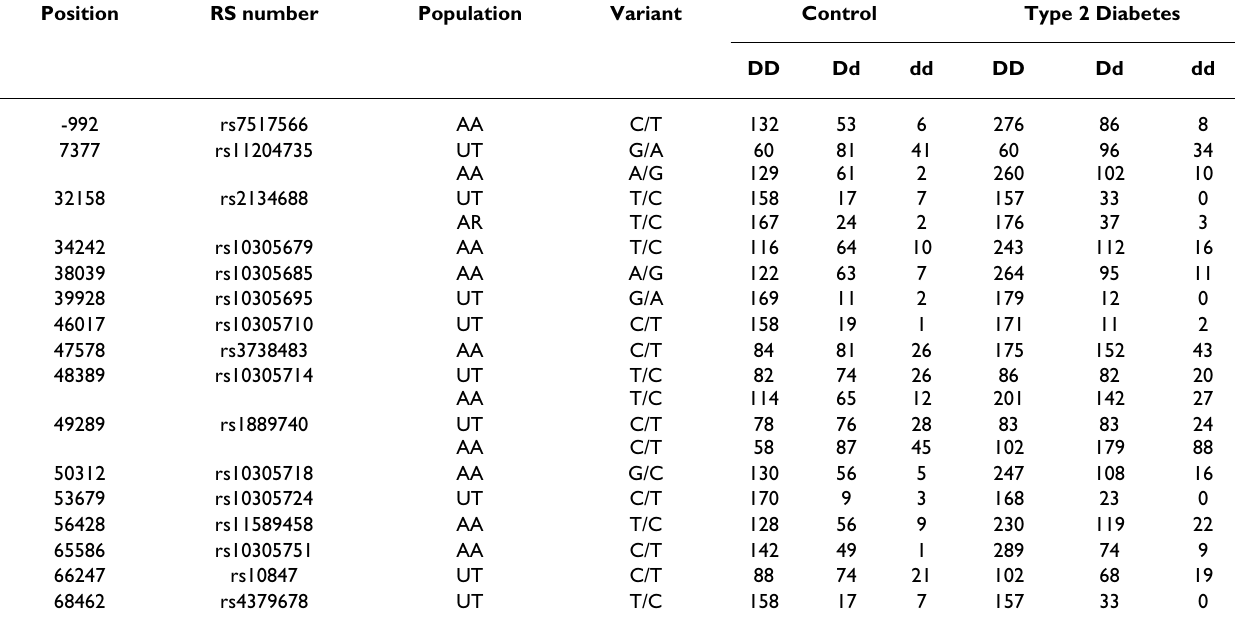
Table 3: Raw counts of cases and controls by genotype for ARNT region SNPs in Caucasians and African Americans